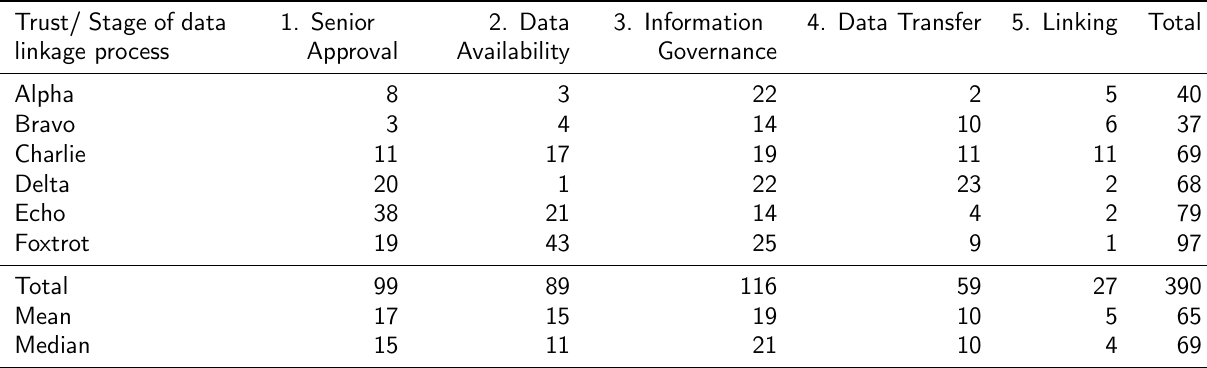
Table 2: Time span (in calendar weeks) to complete each step per trust Trust/ Stage of data